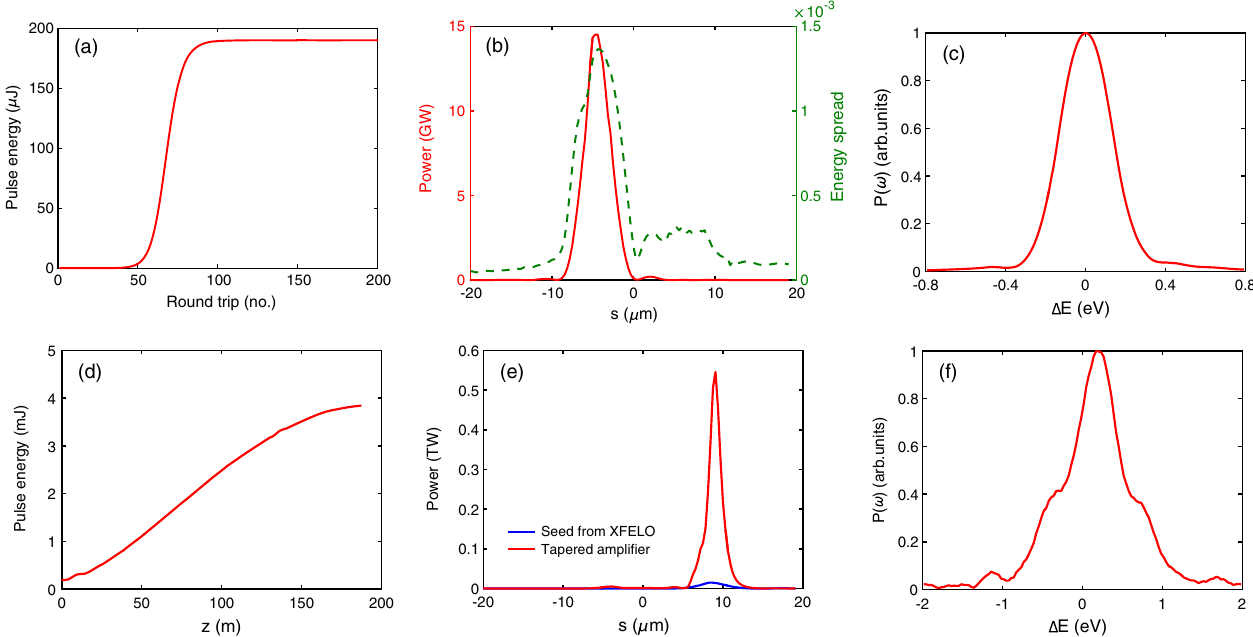
FIG. 7. The start-to-end simulation results for XFELO with the 33% crystal mirror output coupling is shown in the top row of panel: (a) output pulse energy growth at different round trip, (b) power profile (red solid line) and beam energy spread (green dashed line), (c) spectrum for XFELO output. The bottom row plots the out pulse energy gin in the tapered FEL (d), seeding from XFELO (blue line) and output power profile (red line) (e), and the spectrum at the end of undulators (f).